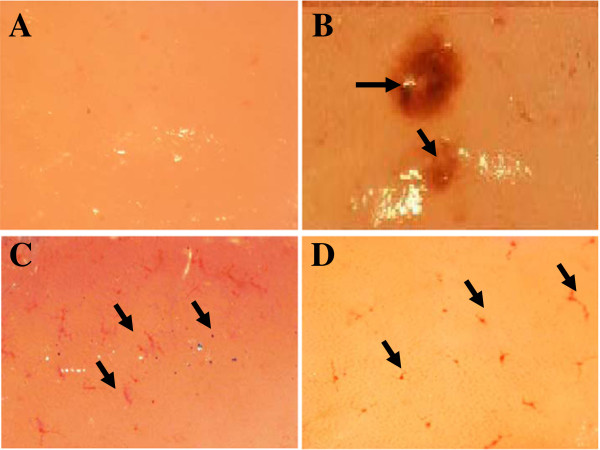
Microscopic observations (3X) of water-immersion restraint stress (WIRS) induced gastric lesions. A: Gastric tissue of normal rat (no lesions). B: Gastric tissue of a rat exposed to 3.5 h of WIRS (Developed gastric ulcer as shown by the arrow). C: Gastric tissue of a rat exposed to 3.5 h of WIRS plus palm vitamin E (PVE) (Developed petichae hemorrhage as shown by the arrows). D: Gastric tissue of a rat exposed to 3.5 h of WIRS plus α-tocopherol (α-TF) (Developed petichial hemorrhage as shown by the arrows).